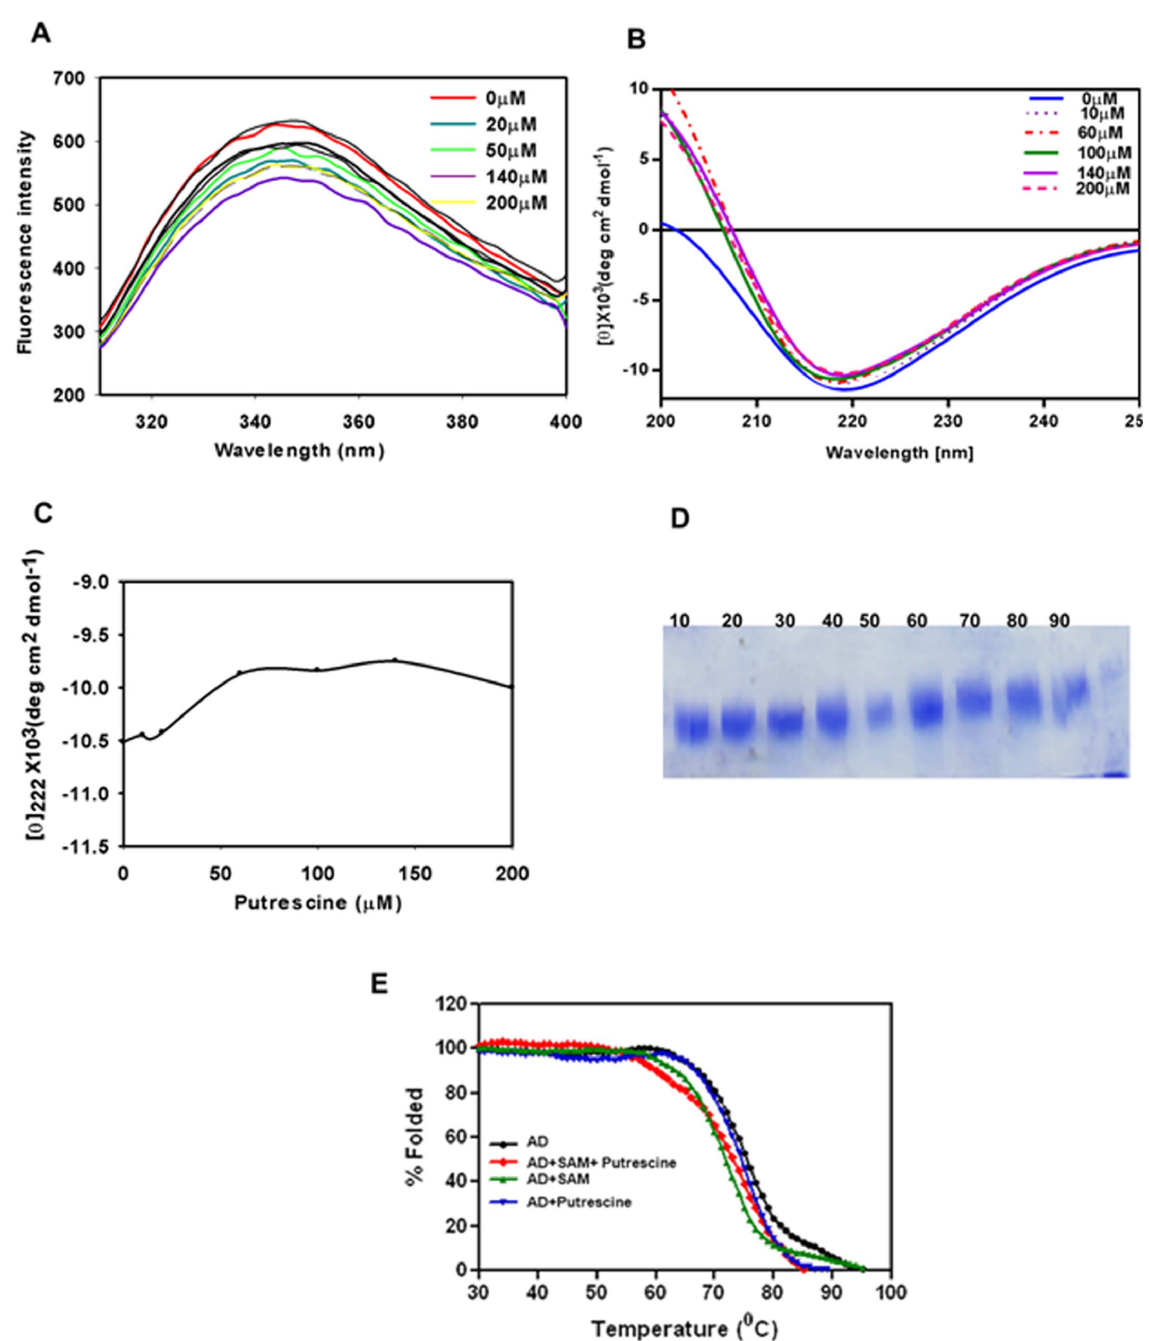
Figure 6. Putrescine binding analysis by fluorescence and far-UV CD spectroscopy. (A) Effect of increasing concentration of putrescine on tryptophan fluorescence shows putrescine quench L. donovani ADL in non-interpretable manner. (B) Far-UV CD spectra with increasing concentration of putrescine show change in secondary structure with increasing putrescine concentration. (C) Change in secondary structure, with increasing concentration of putrescine (0–200 m M) was monitored by molar ellipticity value at h 222 , curve showing change in secondary structure with increasing concentration of putrescine upto 50 m M. (D) Limited proteolysis with increasing concentration of putrescine (10–90 m M) also does not show effect on folding pattern of L. donovani ADL. (E) Thermal denaturation profiles of native ADL (black), L. donovani ADL in complex with putrescine (blue), L. donovani ADL in complex with SAM (green) and L. donovani ADL in complex with both SAM and putrescine (red) reveals substrates binding causes decrease in thermal stability of L. donovani ADL. doi:10.1371/journal.pone.0065912.g006 surrounding tryptophan residues may also interfere with the concentration of putrescine up to 50 m M (Figure 6B and 6C) tryptophan fluorescence (Figure 6A). The secondary structure and then remains constant, suggesting that the ADL binds content of L. donovani ADL show changes with increasing putrescine as well. The observed change in secondary structure